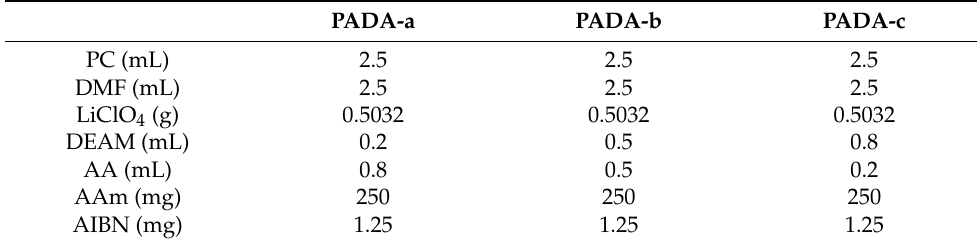
Table 1. Proportion composition of PADA gel